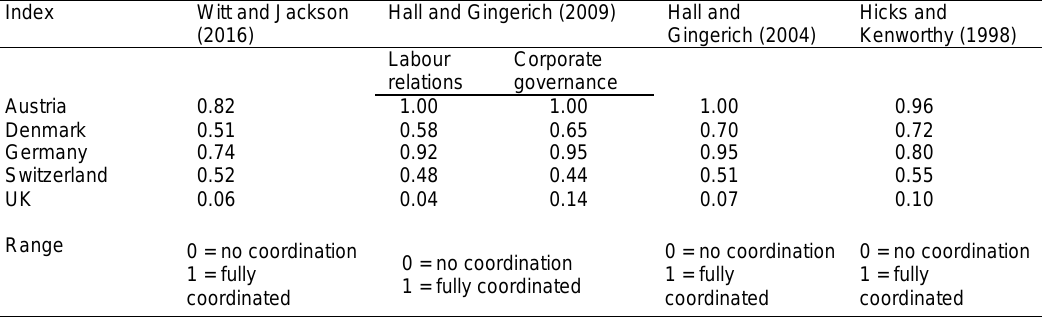
Table 1. Varieties of Capitalism coordination index scores of the five countries